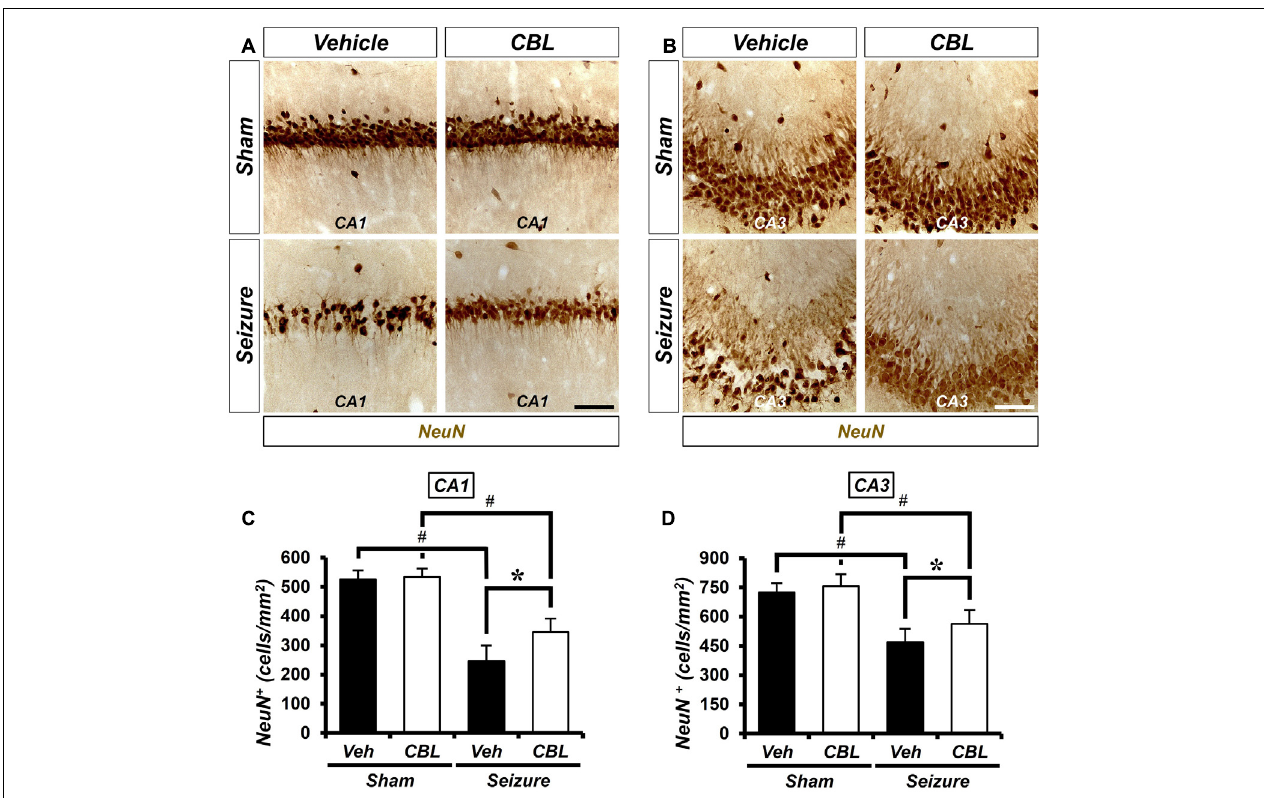
FIGURE 2 | Cerebrolysin increases the density of live neurons after pilocarpine-induced seizure. The administration of cerebrolysin decreases neuronal death after pilocarpine-induced seizure. (A,C) NeuN (+) neurons in the hippocampal CA1 and CA3 regions. After a seizure, the administration of cerebrolysin for 1 week increased the density of live neurons in the hippocampal CA1 and CA3 regions compared with the seizure-vehicle groups. Scale bar = 100 µ m. (B,D) Graphs that show the density of live neurons. The data are the mean ± SEM, n = 5 from each sham group. N = 5–7 for each seizure group. * p < 0.05 vs. vehicle-treated group; # p < 0.05 vs. sham-operated group [Kruskal–Wallis test with post hoc test: (C) Chi square = 17.722, df = 3, p = 0.001, (D) Chi square = 17.024, df = 3, p =